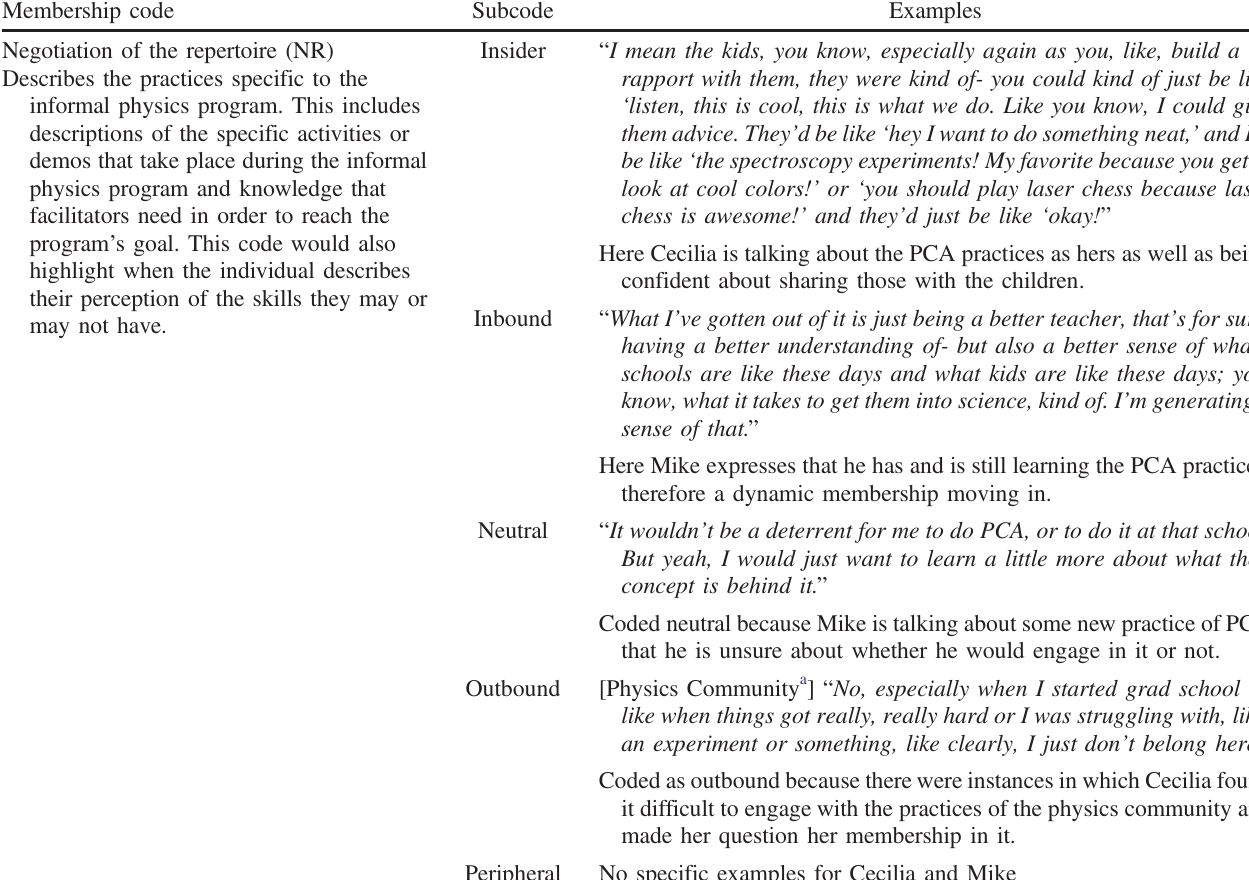
TABLE V. Examples and explanations for each subcode under the negotiation of the repertoire